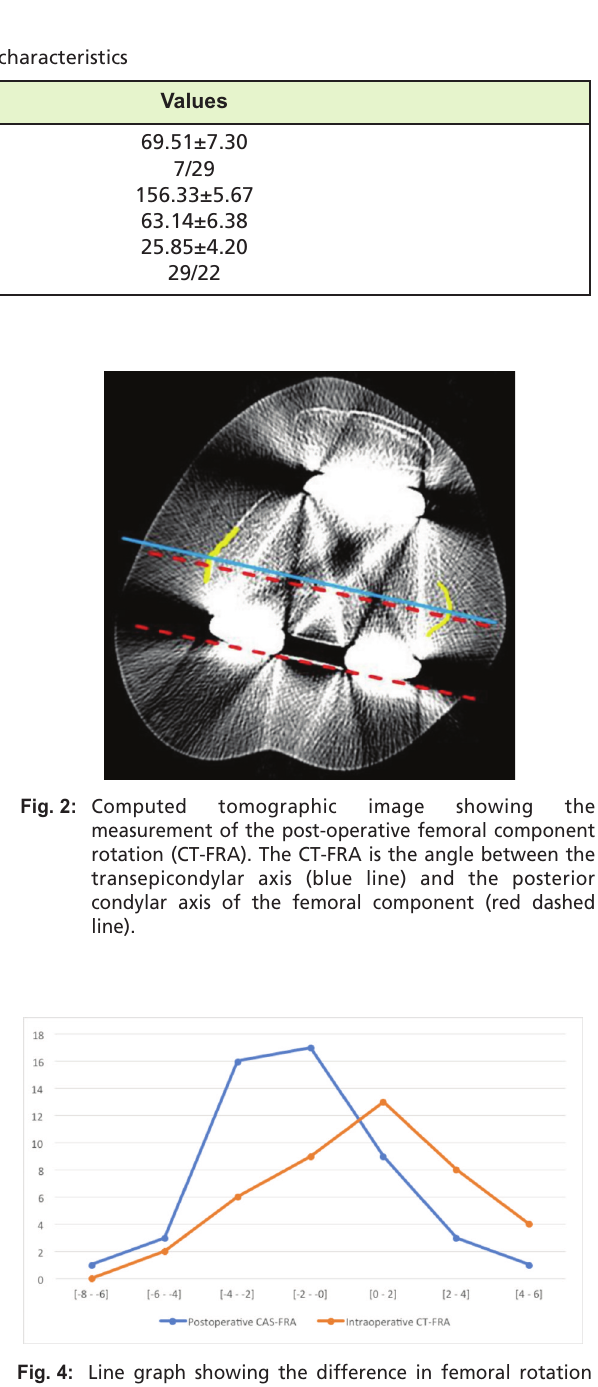
Line graph showing the difference in femoral rotation Fig. 4: alignment between the intra-operative computer- assisted navigation data (CAN-FRA, red line) and the post-operative computed tomography measurements (CT-FRA, blue line).